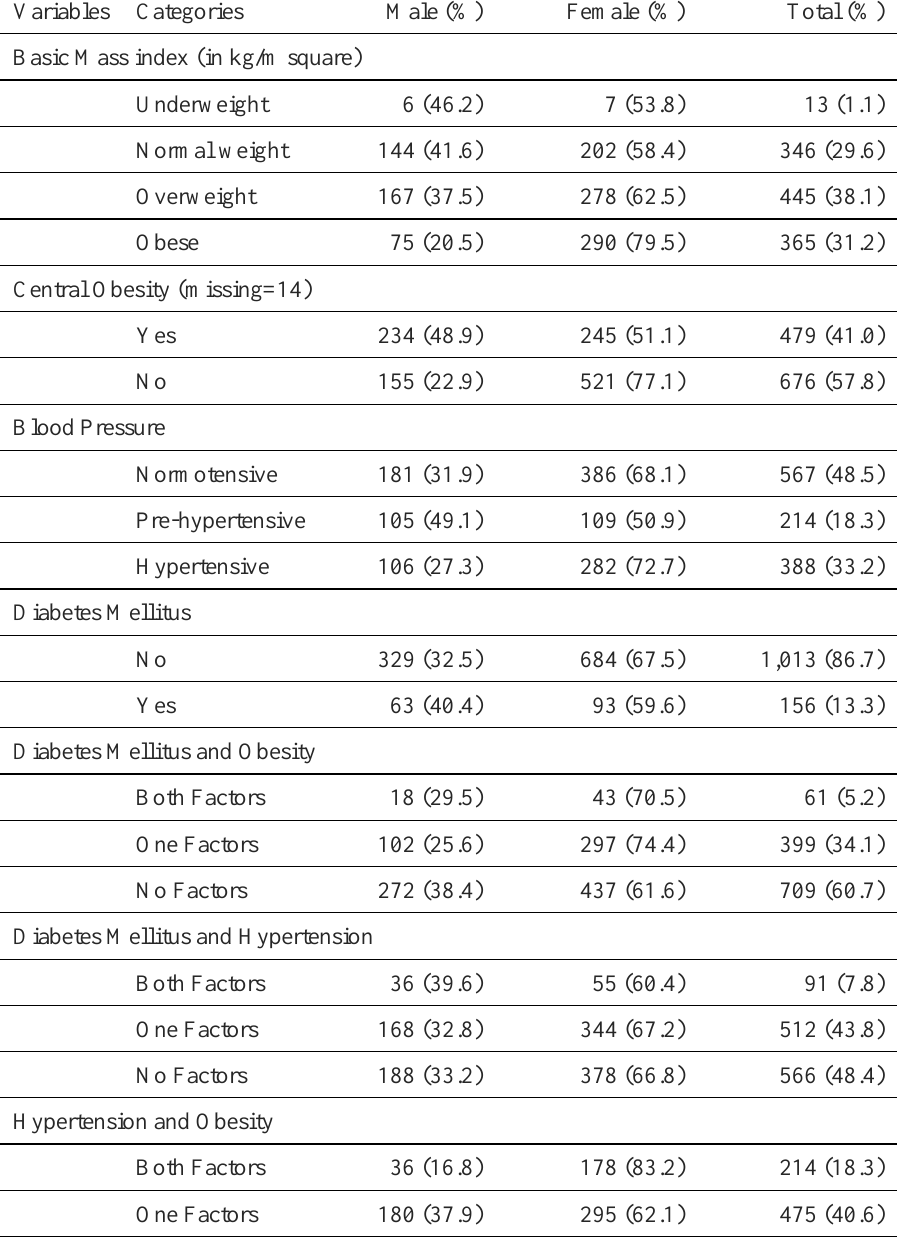
Table 3: Frequency distribution of pathophysiological risk factors for NCDs of study participants